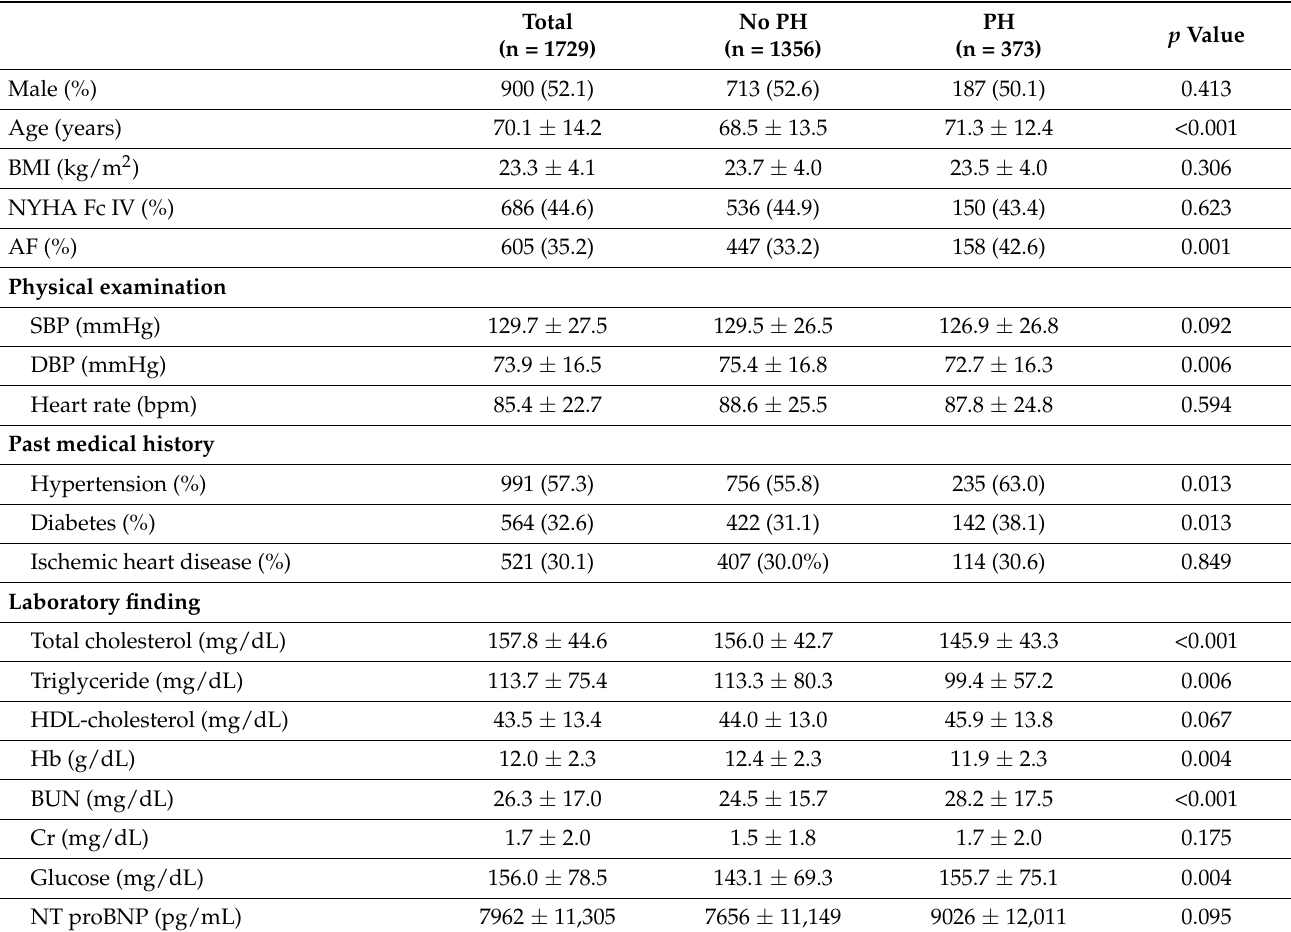
Table 1. Comparison of baseline clinical characteristics and echocardiographic data according to the presence of pulmonary hypertension at follow-up echocardiography.